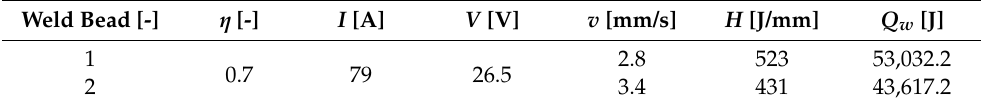
Table 1. Welding process parameters.